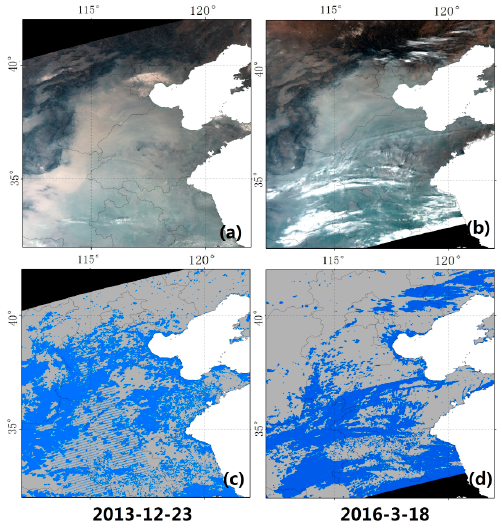
Figure 4. Two-day VIIRS true color images ( a , b ) and NOAA cloud mask result ( c , d ) over the NCP on 23 December 2013 and 18 March 2016. The cloud pixels are represented in blue in the cloud mask result.